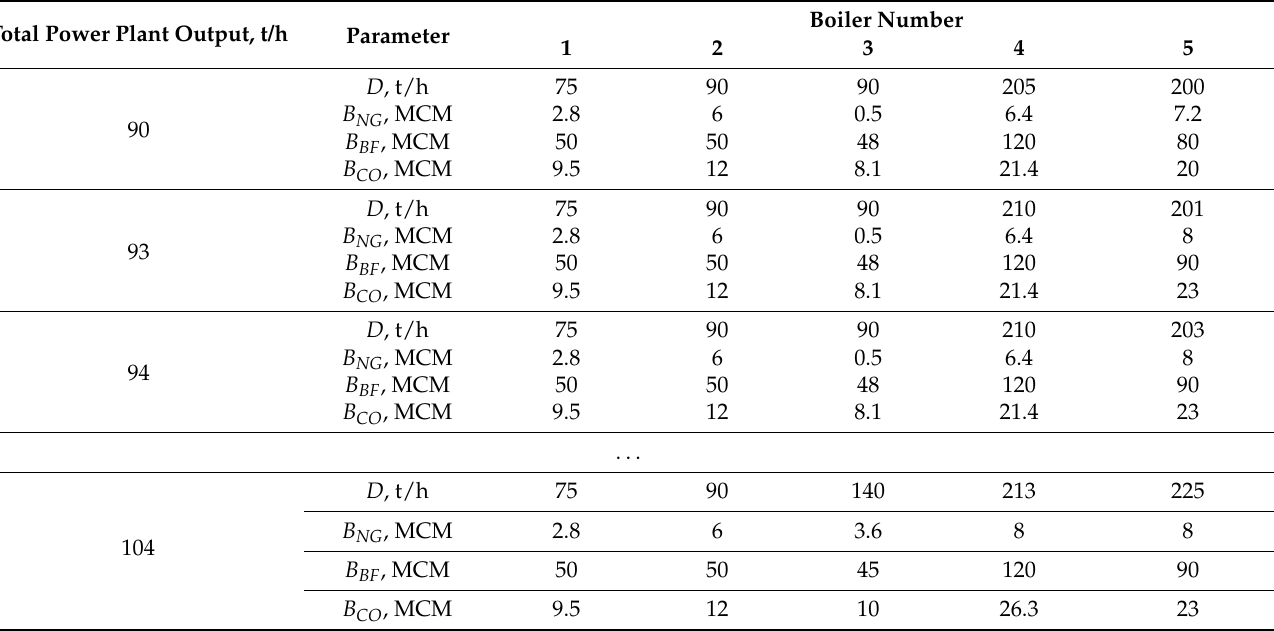
Figure 5. An Example of the Thermal Scheme of an Industrial Power Plant. Table 6. Planned Optimal Boiler Units Operating Modes of the Studied Industrial Power Plant in the Winter Period.